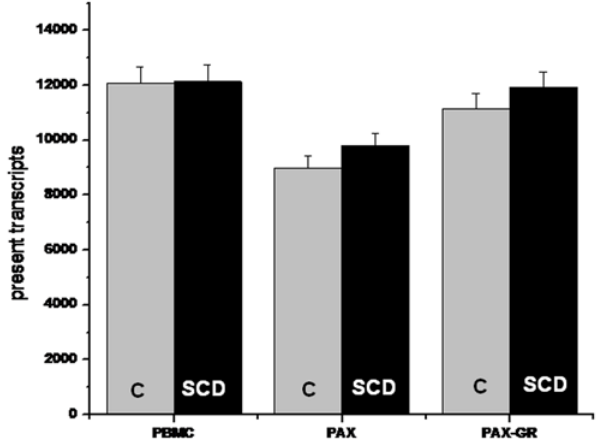
Figure 4. Venn diagram showing the relationship of present calls between PBMC, PAX and PAX-GR in SCD